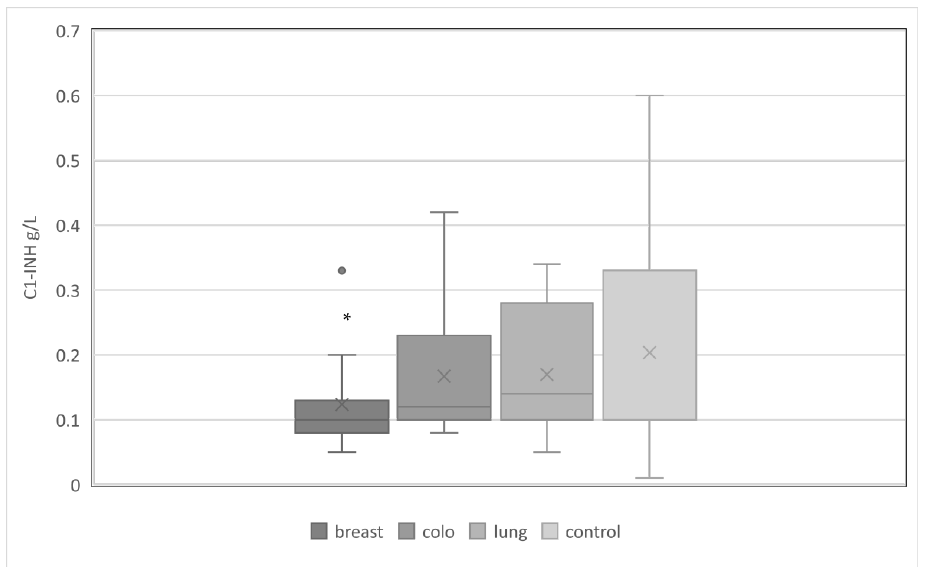
Figure 1. The serum concentration of C1-INH in study groups with C1-INH-AAE. Legend: C1-INH: C1 inhibitor; breast — breast cancer; colo — colorectal cancer; lung — lung cancer; * — significantly lower average concentration of C1-INH in patients with breast cancer compared to other groups, p < 0.05.